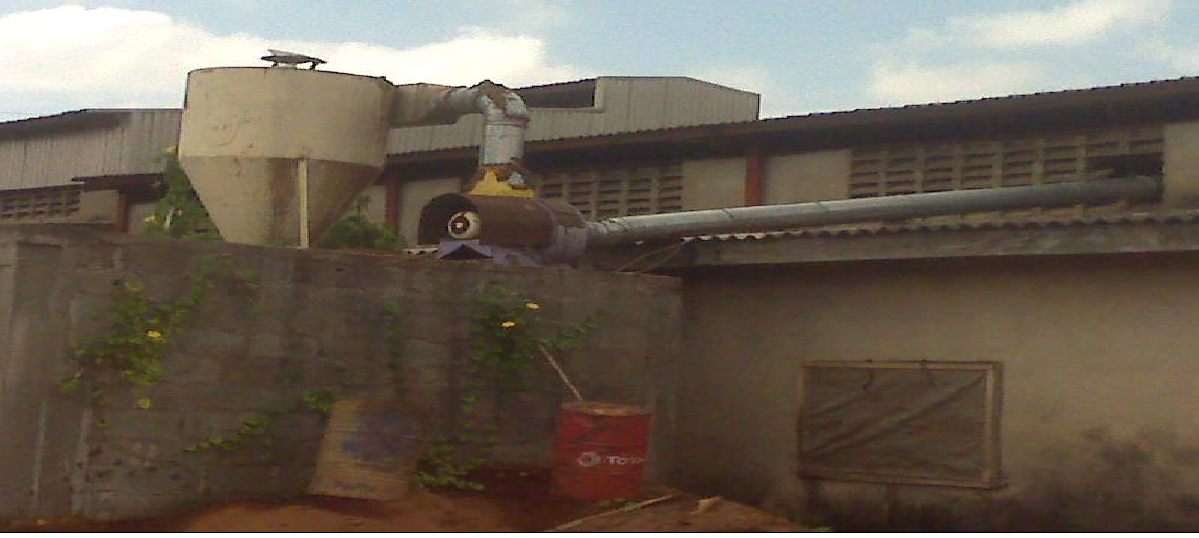
Fig. 10. Suction excavator or vacuum